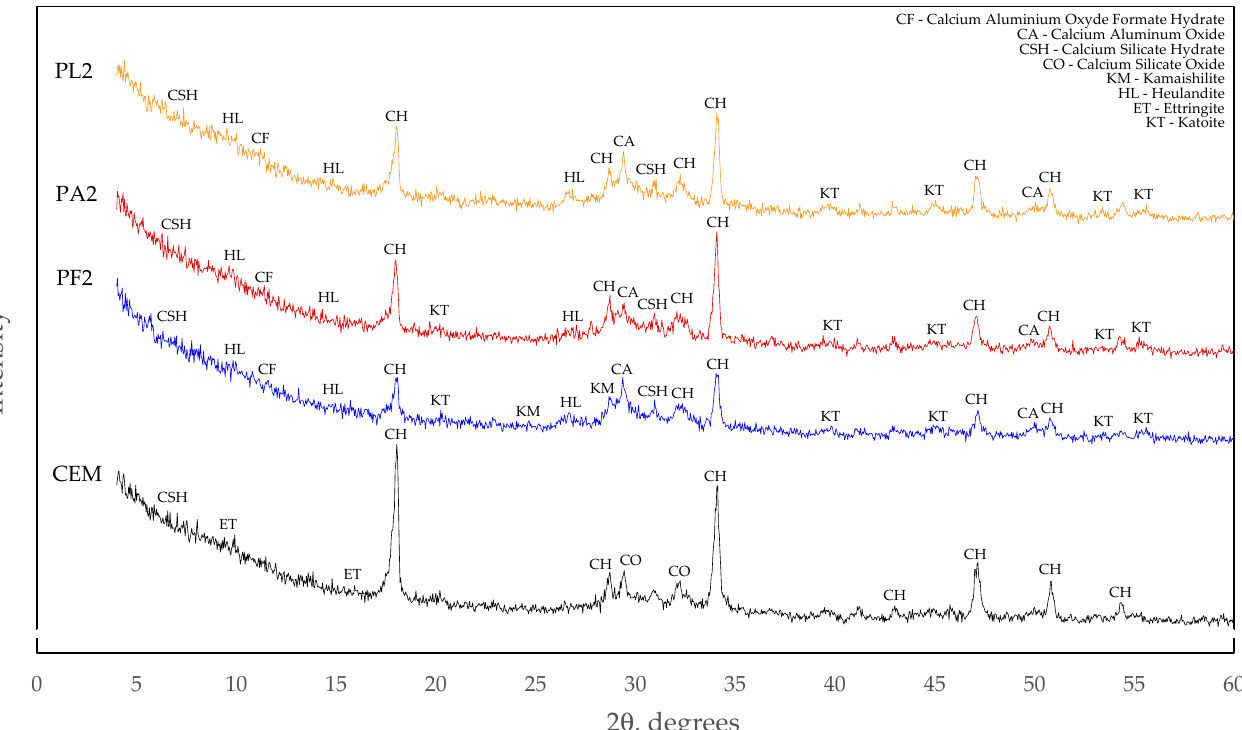
Figure 8. X-ray diffraction images of hardened cement pastes at 90 days.